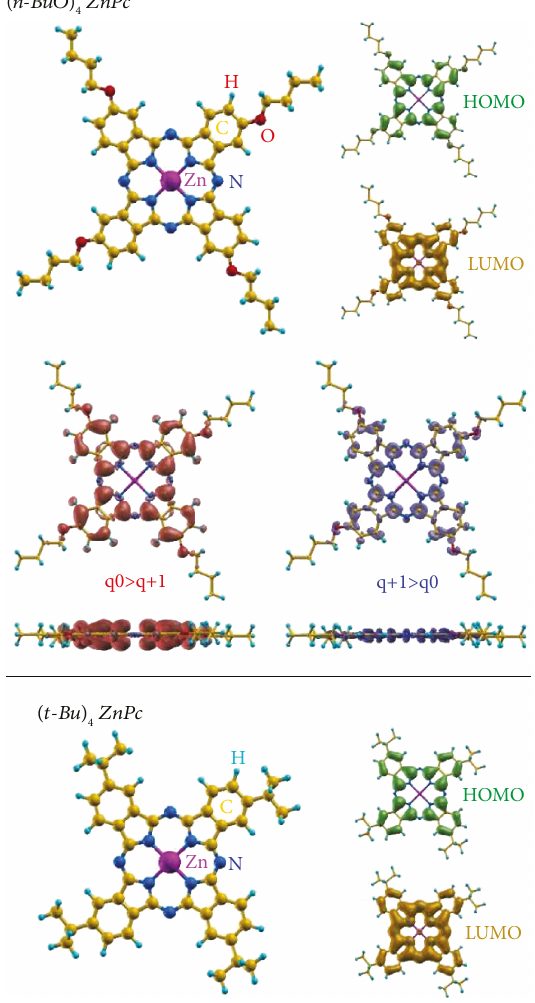
Figure 3: (a) Optimized geometry and Ψ 2 plots of frontier ZnPc. Di ff erence density maps (positive and orbitals of ( n -BuO) 4 negative values, top and side views) of the charge density of ( n -BuO) ZnPc and [( n -BuO) ZnPc] + sampled at 0.0005 electrons/ 4 4 Å 3 . Charge is depleted from red regions, basically corresponding to the ( n -BuO) ZnPc HOMO, when the molecule is oxidized. Part 4 of such depleted charge is accumulated in blue regions, mainly localized in the molecular σ plane. Such accumulation of charge around the nuclei is connected with the lower availability of electrons in positive molecular ions for further ionization processes. (b) Optimized geometry and Ψ 2 plots of frontier orbitals of ( t -Bu) 4